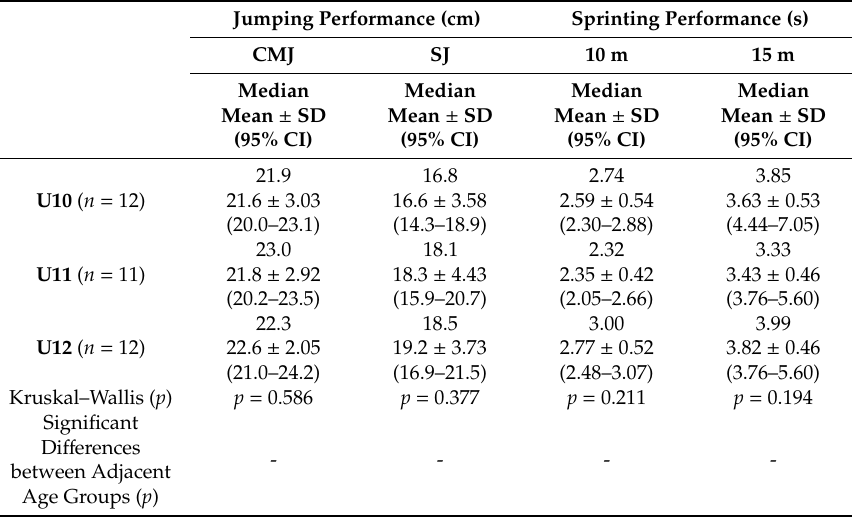
Table 3. Jumping and sprinting performance in relation to age